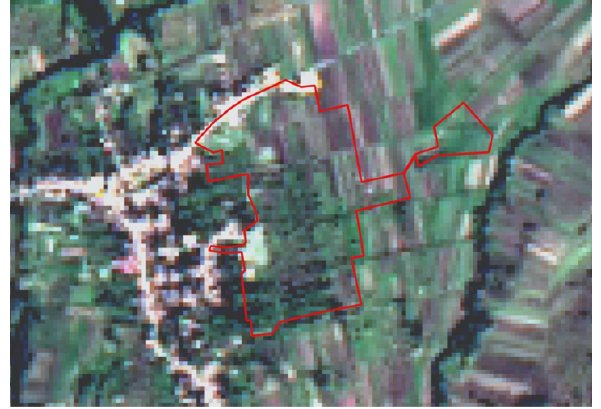
Figure 4. Ulpia Traiana Sarmizegetusa site limits overlaid on Landsat-8 image from 05.10.2013 (©Contains modified Landsat-8 imagery)